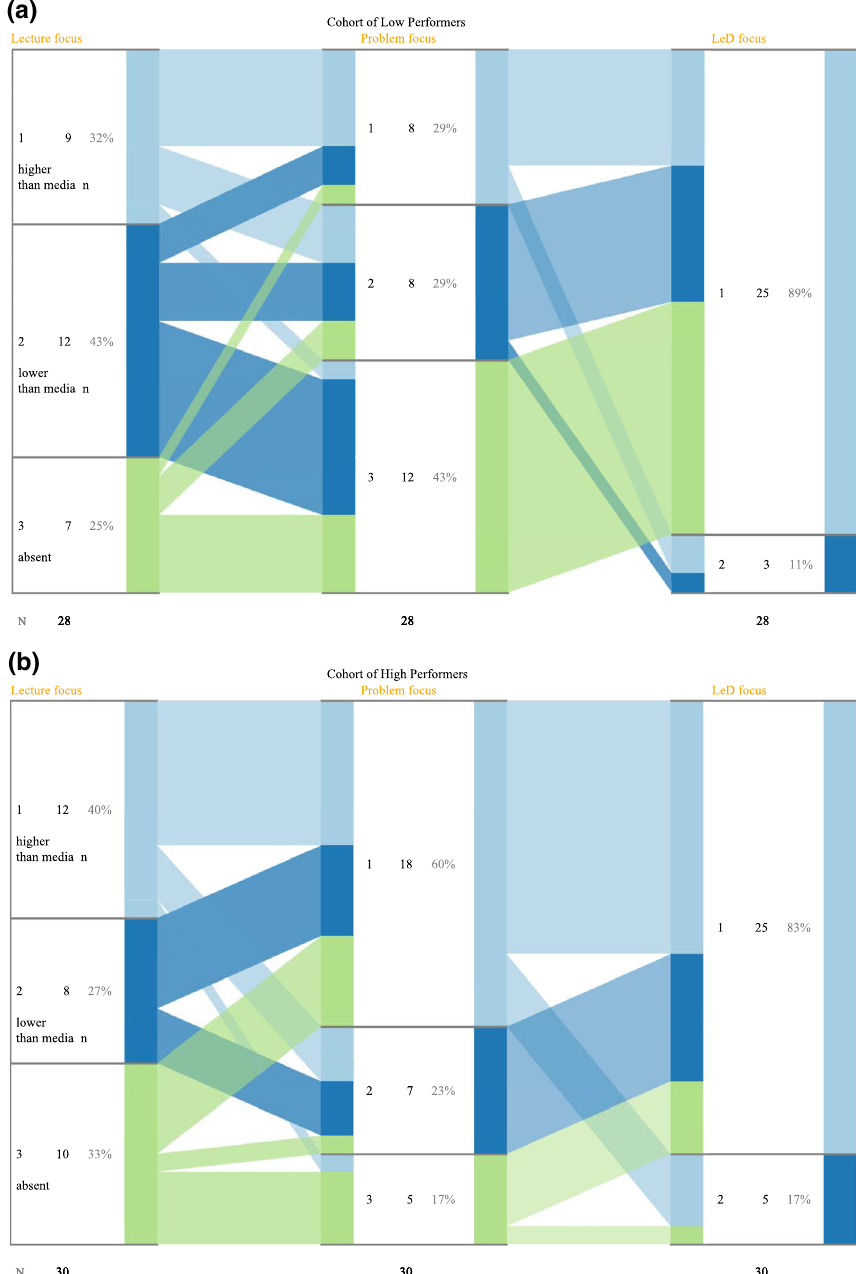
Fig. 6 iSAT analysis of test scores for post BookRoll activity after the lecture focus, problem focus and LeD (L P) focus phases for a transition pattern of the low performers. b transition pattern of the high +